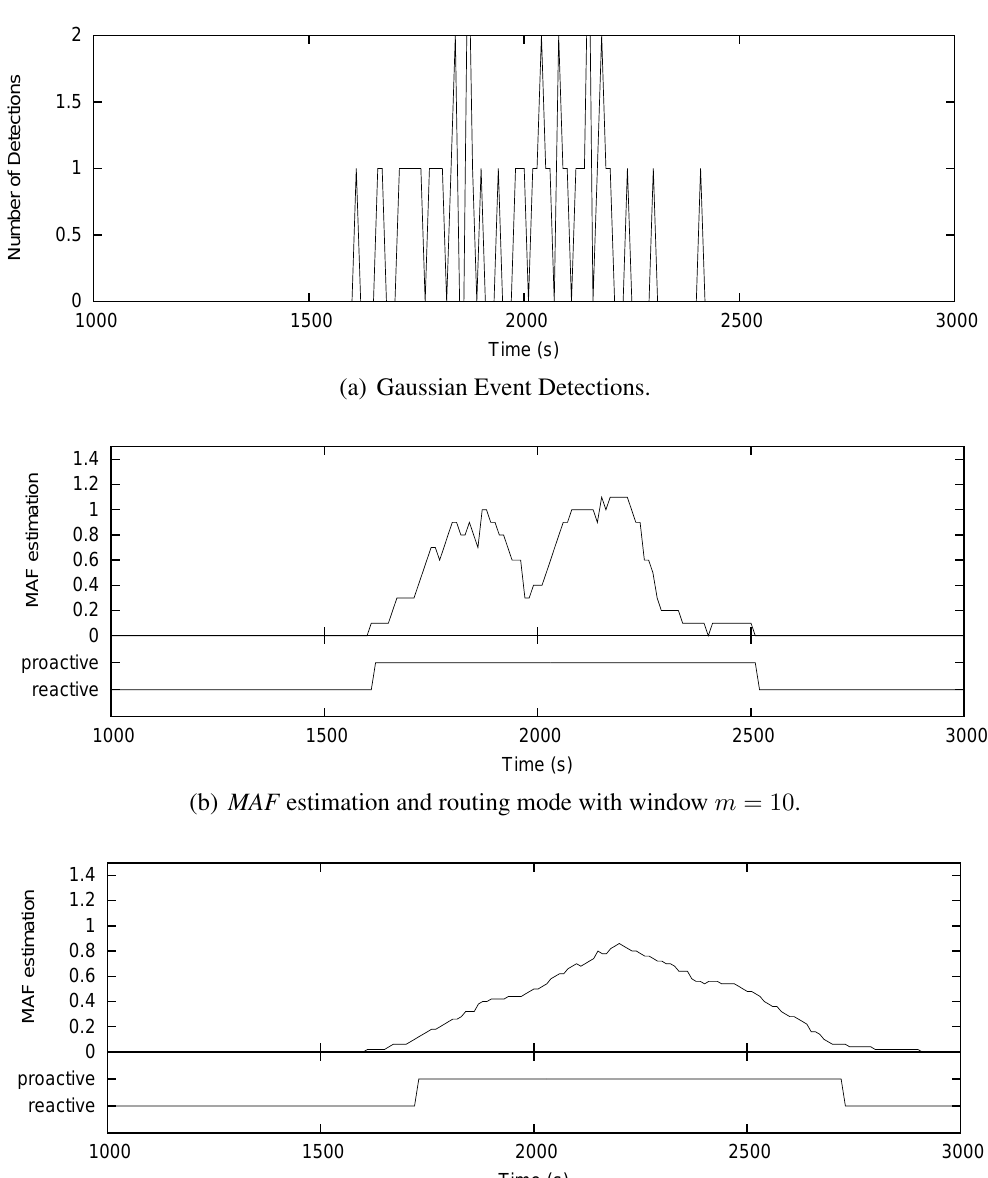
Figure 8. Multi-MAF’s adaptive model (Gaussian event